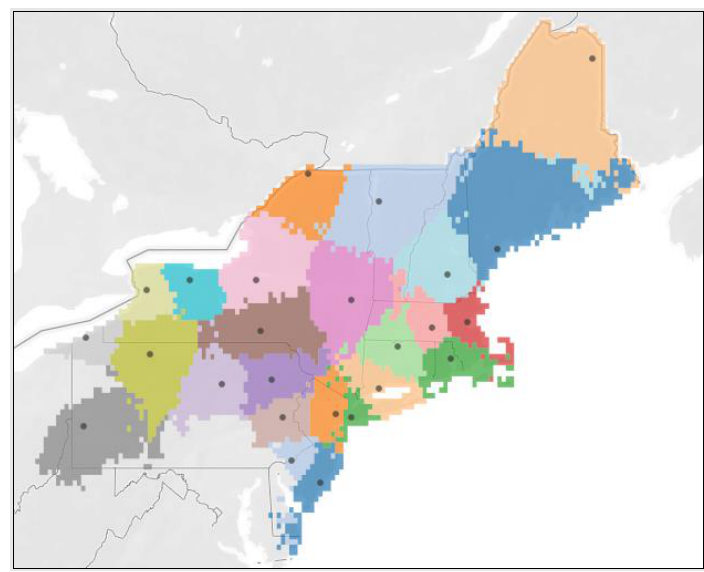
Figure 3. Actual Meteorological Year (AMY) weather locations in the northeast United States.